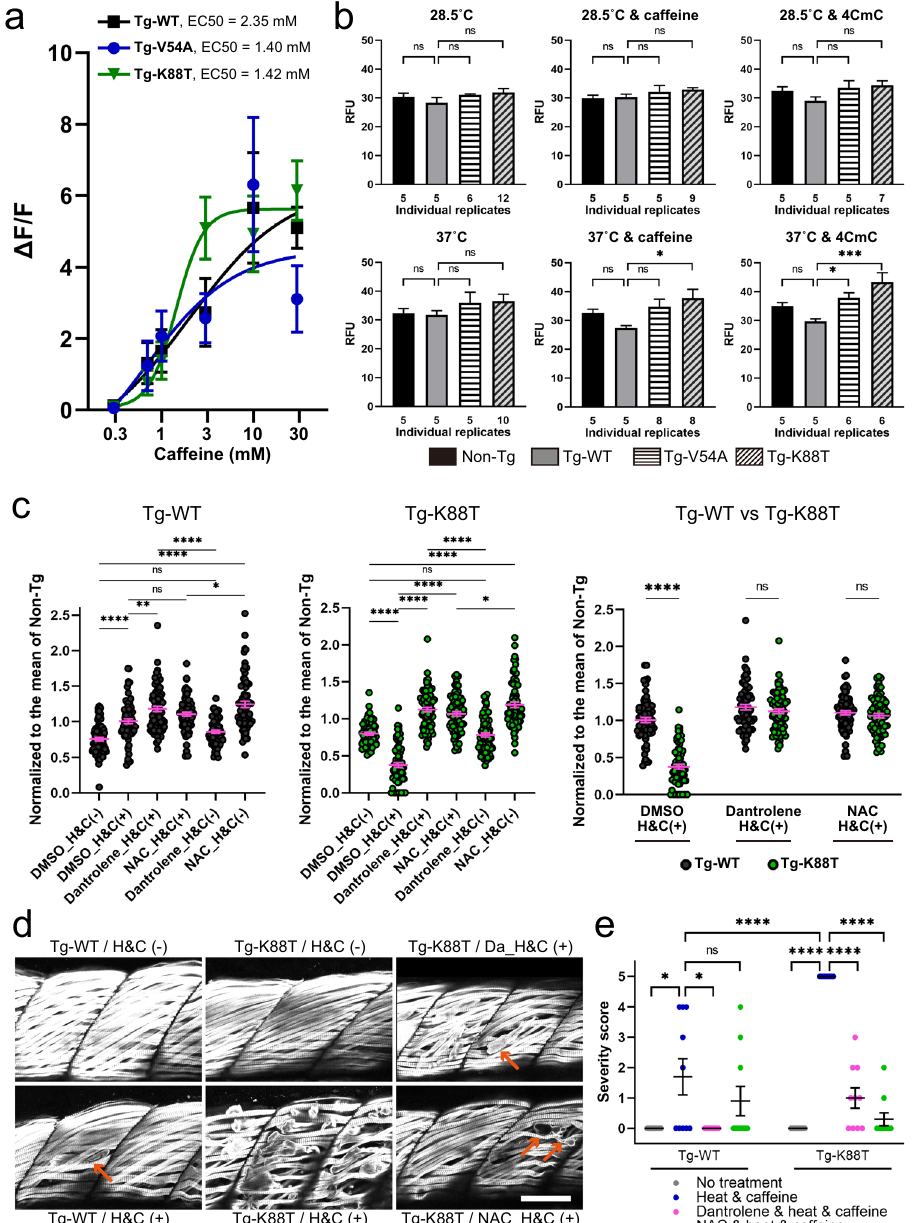
Fig. 3 Junctin mutant zebra fi sh exhibit heat plus caffeine provoked cellular pathology that is rescued with dantrolene or N-acetylcysteine. a Concentration dependence of caffeine-induced calcium release in Tg- fi sh myo fi bers at room temperature. A leftward shift is seen with K88T (see